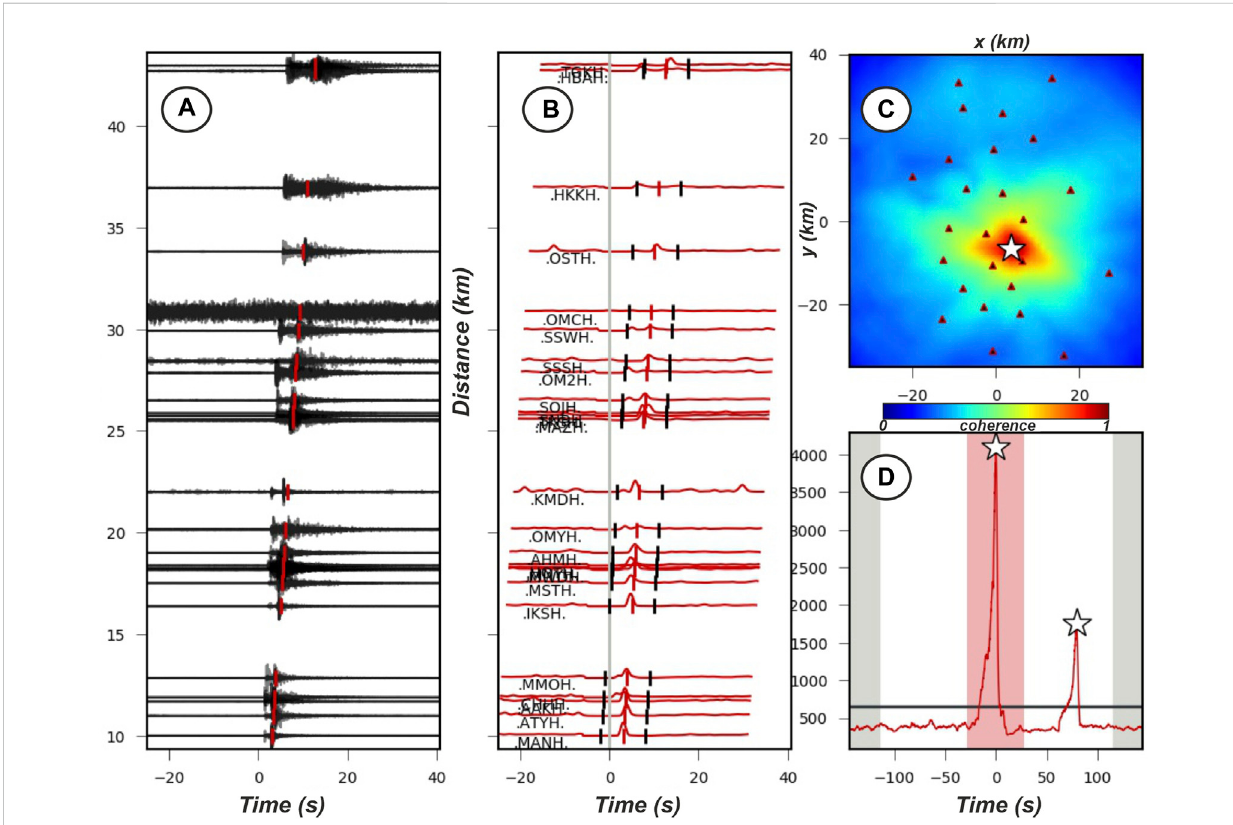
FIGURE 3 Exampleofarrival-timecoherencedetectionforanM V 2.5earthquakeon16/05/2011at13:25:04(JST). (A) Waveformsusedfordetectionssortedby epicentral distance. (B) Characteristic functions (normalized amplitude) calculated for each station. They are corrected according to the S-wave velocity (red lines) for the travel time and stacked to obtain the fi nal global image function in (D) . The markers indicate the best fi t arrival times for the P- and S- phases.The blackmarkers indicate thetime windowoverwhichthecharacteristicfunctionamplitudeisconsideredfor thede fi nitionoftriggered or not-triggeredstations. (C) Stackofthecoherencemapforthesearchregionwithavailableseismicstations(blacktriangles)andtheeventdetected(white starat0 s).Thecolorbarshowscoherencevalues. (D) Globalimagefunctionscorrespondingtothebest fi tofthesourcepositionalongaprocessingtime windowcenteredontheorigintimeofthedetectedearthquake.Thewhitestarindicatesthedetectedeventabovea fi xedthresholdvalue(blackline).The white star on the right, at 75 s, is a second event, which was subsequently